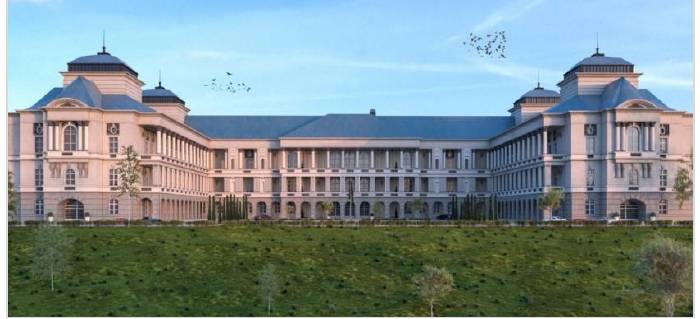
Figure 12 Photograph illustrating the front view of Darul Aman Palace (Issa,